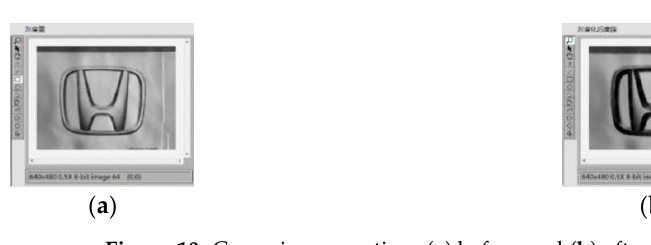
Figure 10. Corrosion operation: ( a ) before and ( b ) after.